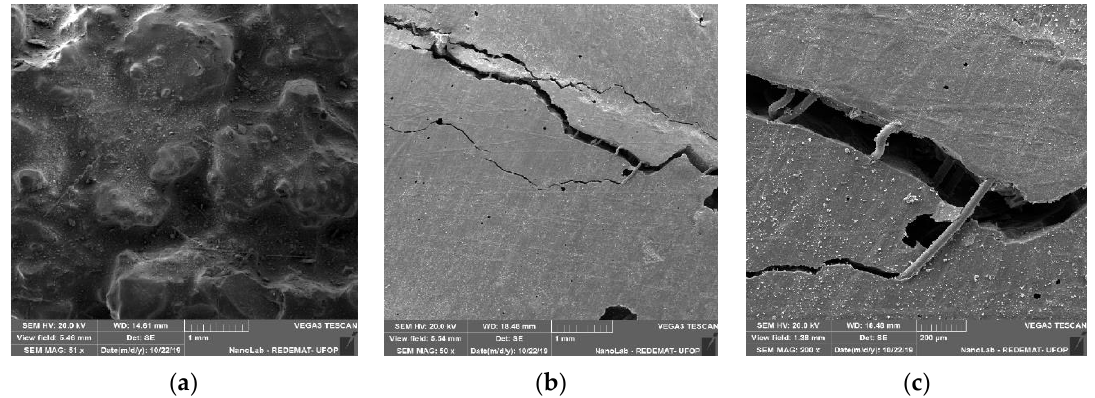
Figure 19. Flexural ( a ) (51× magnification) and lateral ( b ) (50× magnification), ( c ) (200× magnification) surface of the matrix of epoxy resin and glass fibre.